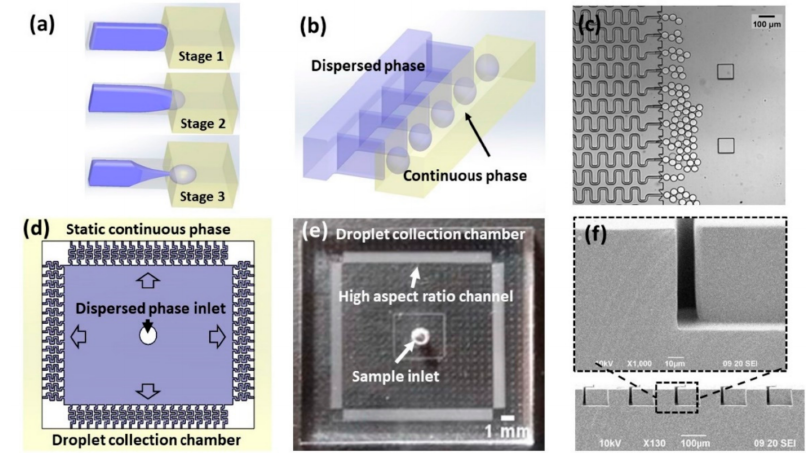
Figure 18. Schematic diagram and photographs of the high-aspect-ratio-induced self-breakup (HIDS) device: ( a ) Schematic representation of the droplet breakup process by Plateau–Rayleigh instability in a single HIDS structure where the dispersed phase (purple) is confined in an energy-unfavorable shape; ( b ) Schematic representation of the parallel integration of an array of the HIDS generators. ( c ) A micrograph of parallelized HIDS generators and generated monodispersed droplets. ( d ) A